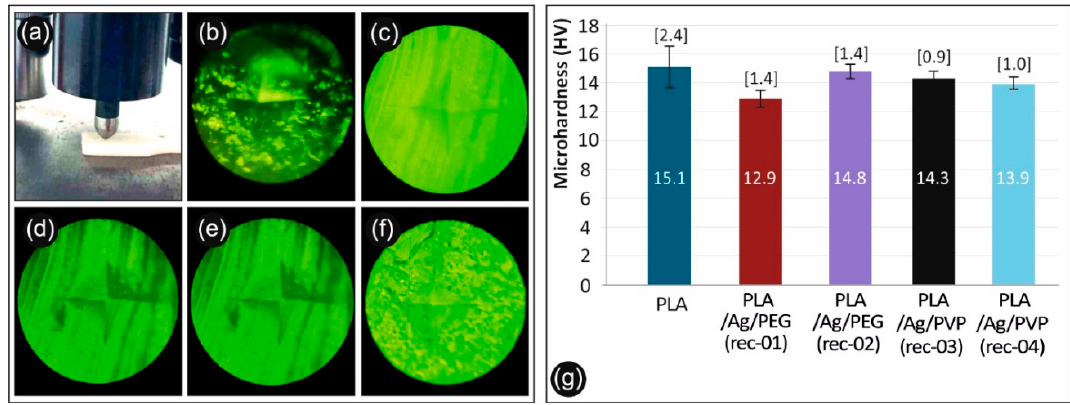
Figure 14. ( a ) Measuring the Vickers Micro-Hardness of a specimen, ( b ) PLA/Ag/PEG (rec 1) specimen, ( c ) PLA/Ag/PEG (rec 2) specimen, ( d ) Pure PLA specimen, ( e ) PLA/Ag/PVP (rec 3) specimen